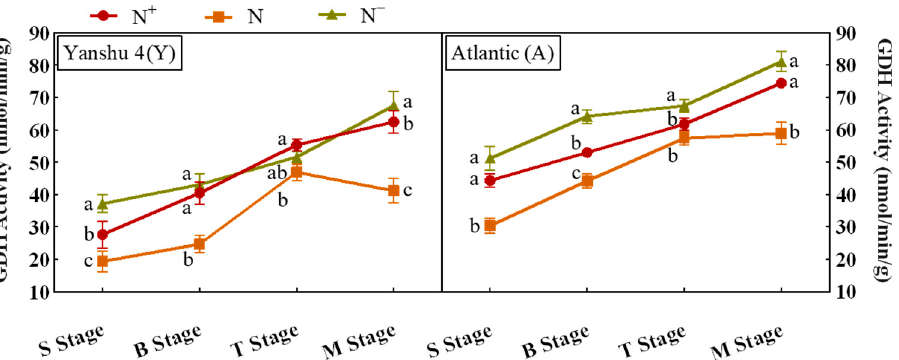
Figure 18. Glutamate synthase (GOGAT) activity in two genotypes of potato leaves under different N supply levels. The amount of 1 nmol NADH is consumed per 1 g fresh weight sample per 1 min is one unit of enzyme activity. S Stage, B Stage, T Stage, and M Stage represent seedling stage, budding stage, tuber expansion stage, and mature stage, respectively. N − , N, N + are different N supply levels, representing low N, normal N, and excess N, respectively. Different letters indicate the difference of enzyme activity under different N application levels in the same period ( p < 0.05).